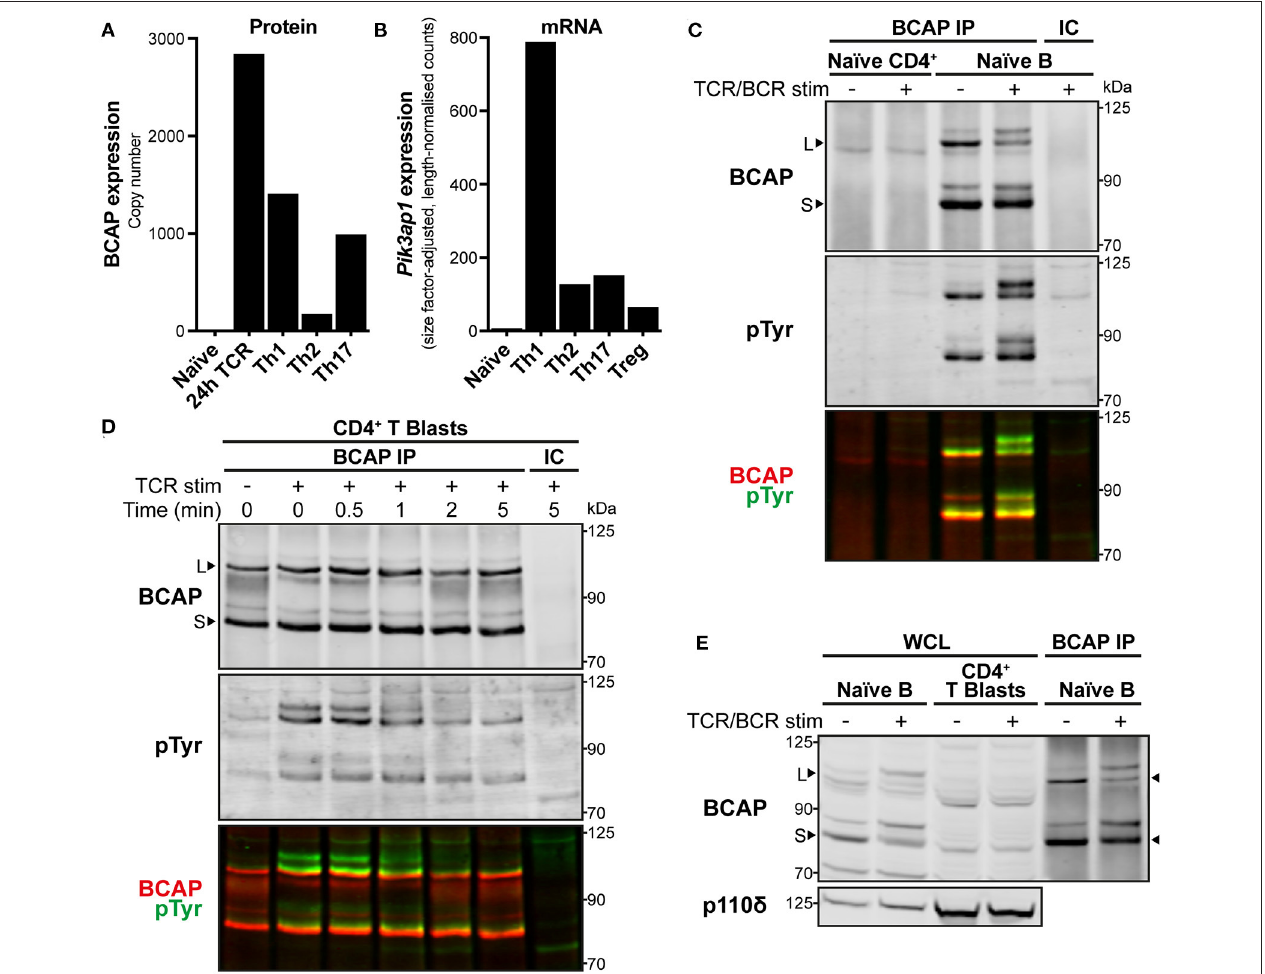
FIGURE 3 | BCAP is upregulated in activated CD4 + T cells and tyrosine-phosphorylated upon TCR stimulation. (A) BCAP protein copy number in mouse naïve CD4 + T cells, 24 h-antigen-activated OT-II CD4 + T cells, and differentiated Th1, Th2, and Th17 CD4 + T cells. Data are from ImmPRes [http://immpres.co.uk; ( 4)]. (B) Expression of Pik3ap1 mRNA in murine naïve splenic CD4 + T cells, in vitro -activated and polarised Th1, Th2, and Th17 CD4 + T cells, and splenic Tregs. Data are from Th-Express [https://th-express.org; ( 33)]. Expression levels in each subtype are calculated as read counts normalised by size factor and transcript length. (C) Immunoblot of immunoprecipitates (IPs) from naïve CD4 + T cells and naïve splenic B cells using anti-BCAP (BCAP IP) or IgG isotype-control antibody (IC). Naïve CD4 + T cells were stimulated by CD3-CD4-crosslinking for 30s and naïve B cells were stimulated with anti-mouse IgM F(ab ′ ) 2 for 2.5min (TCR/BCR stim; + ), or left unstimulated (–). The membrane was probed with anti-BCAP and anti-pTyr and the signals detected for each are overlaid in the third panel in red and green, respectively. Arrowheads indicate the BCAP long (L) and short (S) isoforms. Immunoblot representative of two independent experiments. (D) Immunoblot of IPs from CD4 + T cell blasts using anti-BCAP (BCAP IP) or IgG isotype-control antibody (IC). Cells were stimulated by CD3-CD4-crosslinking (TCR stim; + ) for the indicated times or left unstimulated (–). The membrane was probed with anti-BCAP and anti-pTyr and the signals detected for each are overlaid in the third panel in red and green, respectively. Arrowheads indicate the BCAP long (L) and short (S) isoforms. Immunoblot from one experiment representative of three independent experiments. (E) Immunoblot of whole cell lysates (WCL) from an equal number of naïve splenic B cells and CD4 + T cell blasts, alongside BCAP IPs from naïve B cells to show the location of BCAP long (L) and short (S) isoforms, indicated with arrowheads. Naïve B cells were stimulated with anti-mouse IgM F(ab ′ ) 2 for 2.5min and CD4 + T cell blasts were stimulated by CD3-CD4-crosslinking for 1min (TCR/BCR stim; + ), or left unstimulated (–). The membrane was probed with anti-BCAP and anti-p110 δ as a loading reference. Immunoblot representative of at least three independent